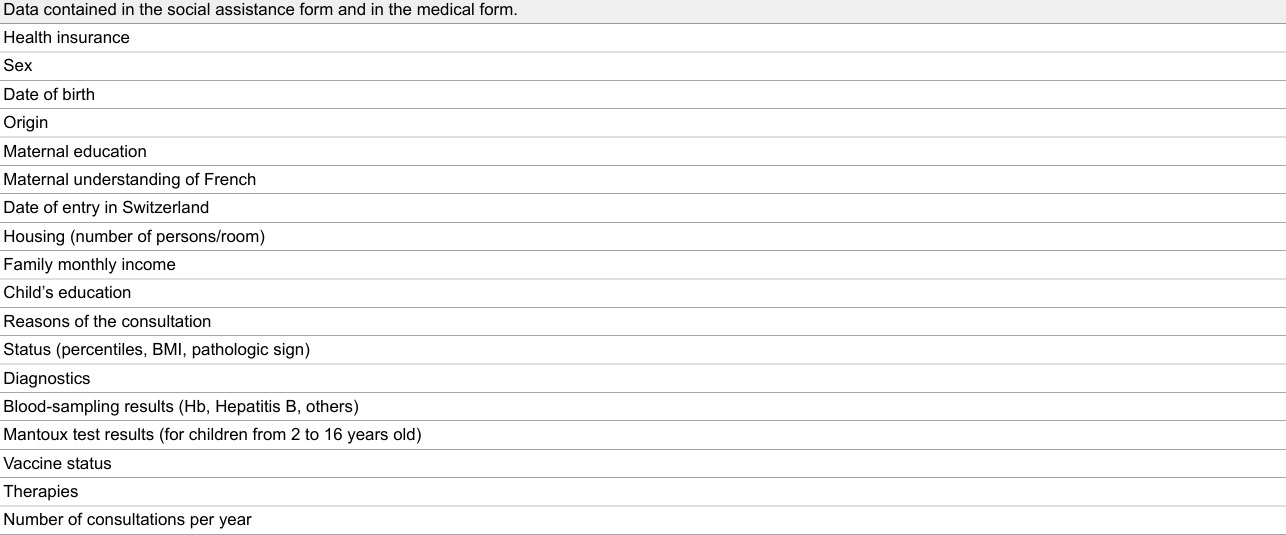
Table 1 Data contained in the social assistance form and in the medical